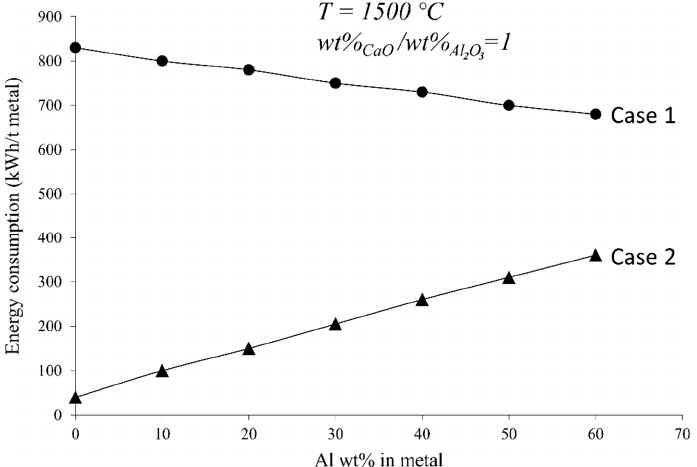
Figure 10. Calculated energy consumption for the Mn-Al alloy production from MnO-CaO slags. Case1: reactants are heated. Case 2: enthalpy of reactions is used to heat the reactants.